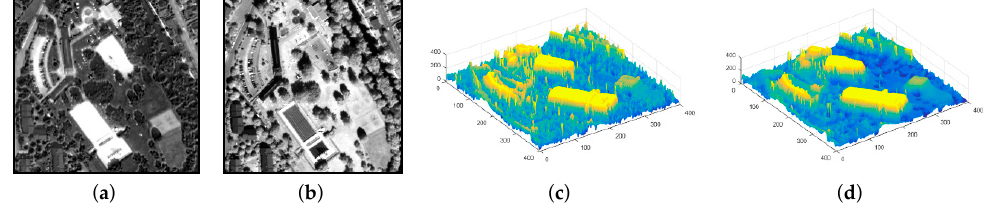
Figure 4. An example of the guided filtered result based on the QuickBird images: ( a ) input image I ; ( b ) the guidance image G ; 3D comparison of band features: ( c ) before and ( d ) after GF. The original image bands were filtered by the generated superpixel-level guidance image with different radius r to model the land-cover objects at multiple scales. Superpixel-guided filter (SGF) features with a series of r were stacked to build multi-scale superpixel-guided filter (MSGF) features: